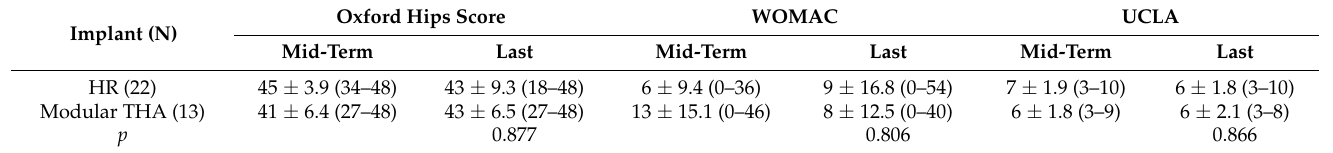
Table 3. Clinical Outcomes of Hip Resurfacing and Modular Total Hip Arthroplasty.